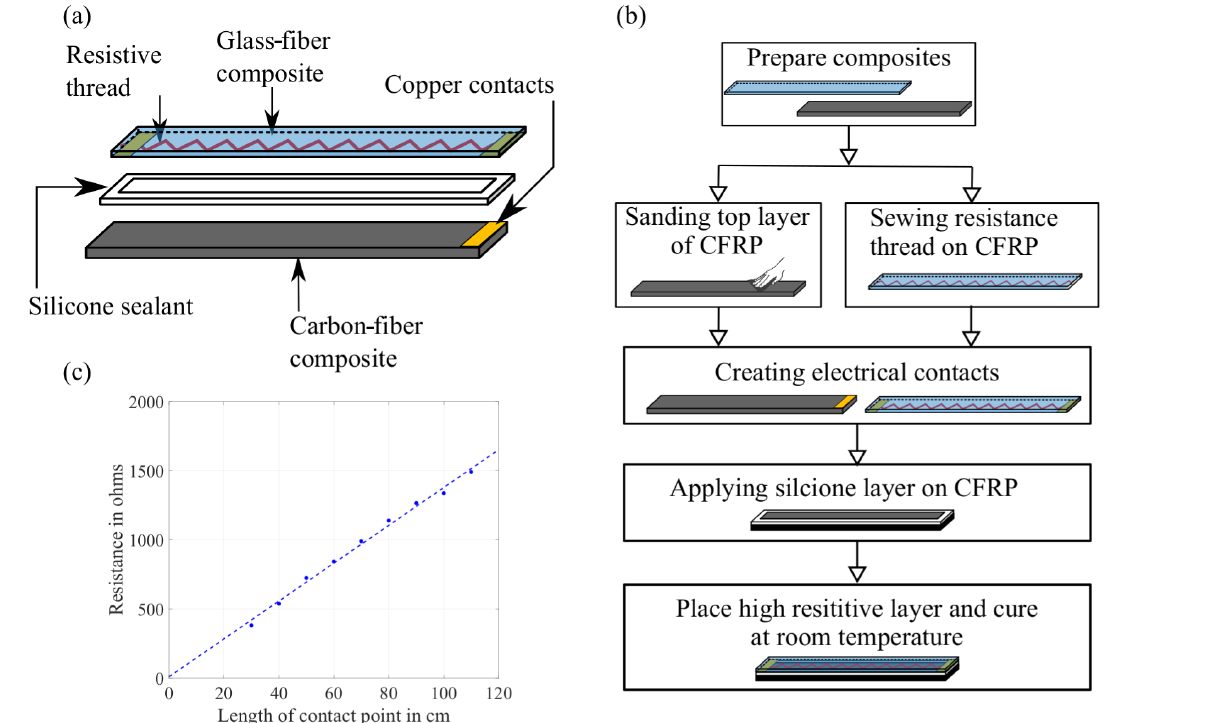
Figure 4. CFRP-based validation sensor: (a) construction, (b) manufacturing process and (c) resistance diagram of sensor at different contact